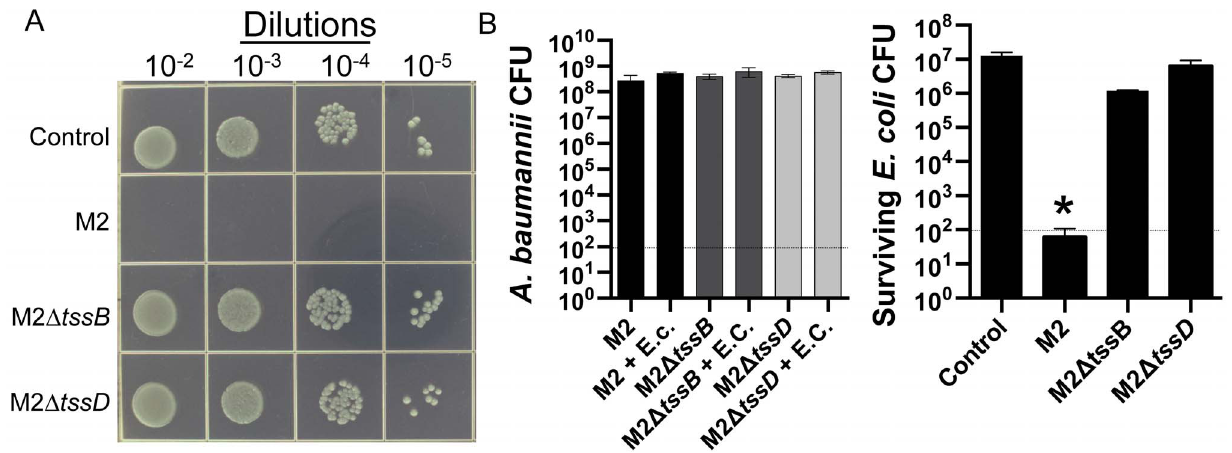
Figure 3. Acinetobacterbaumannii required the products of tssB and hcp to out-compete E.coli. A. Semi-quantitative assessment of surviving E. coli after 4 h mixed with media (Control) or at a 10:1 ratio (10 A. baumannii to 1 E. coli ) with A. baumannii strain M2, M2 D tssB or M2 D hcp. B. Quantitative assessment of the A. baumannii and E. coli DH10B populations. Data represent of 3 biological replicates each performed in duplicate. Error bars represent standard error of the mean of the biological replicates. * Indicates a significant difference ( P , 0.0001) between E. coli CFU observed with or without co-incubation with strain M2. The dotted line on each bar graph of panel B indicates level of detection.